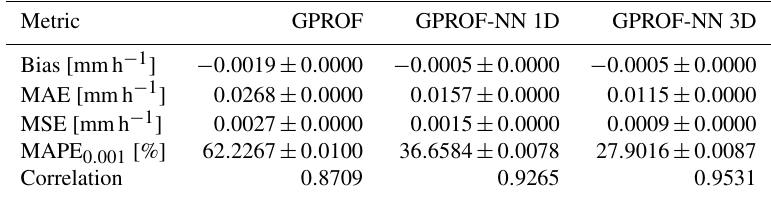
Table C4. The same as Table 4 but for CWP.